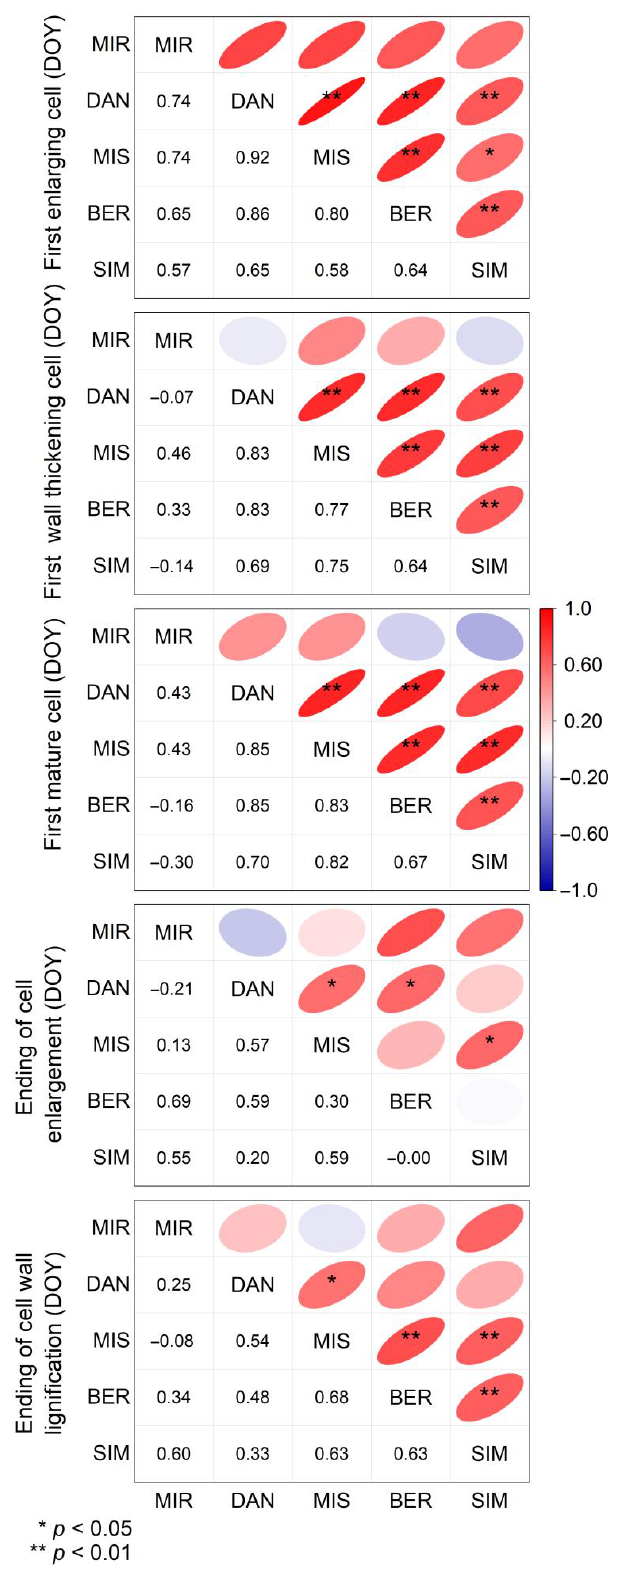
Figure 5. Correlation matrix for the xylem phenology of black spruce between five permanent sites in the boreal forest of Quebec, Canada. Pearson’s r values are represented by both values and ellipse colors. Narrower ellipses represent high correlation, and the asterisks indicate significant correlation